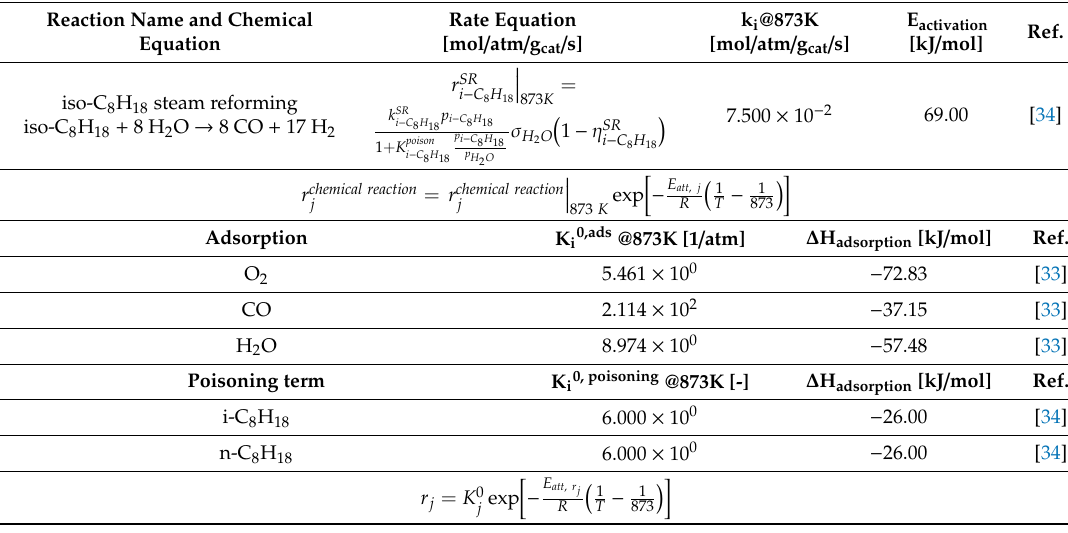
Reaction Name and Chemical